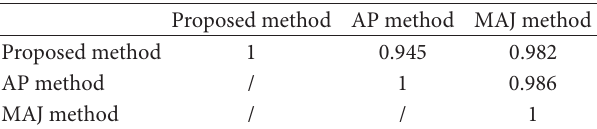
Table 4: Result of correlation analysis.